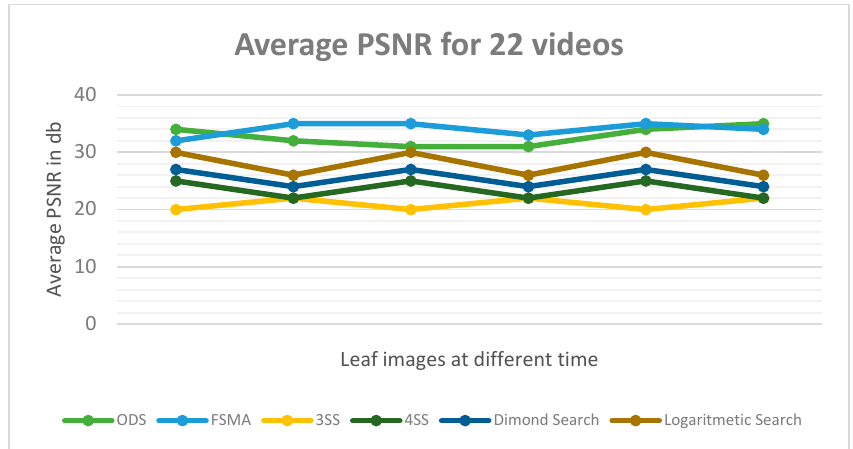
Figure 13. Average PSNR for 22 electron micrographs. Table 6. Confusion matrix and frame location of detction of calcium oxalate crystals.